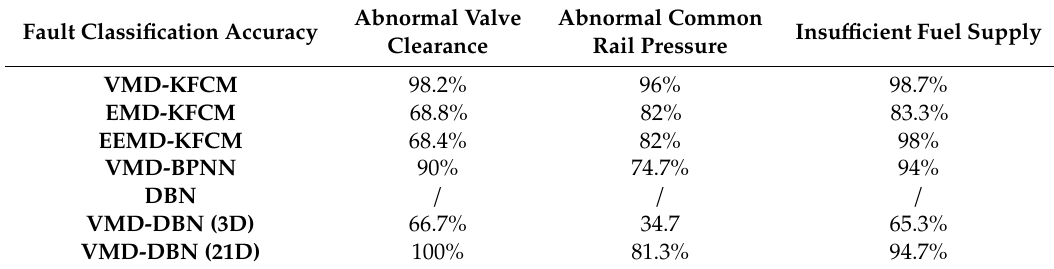
Table 5. Comparison of classification